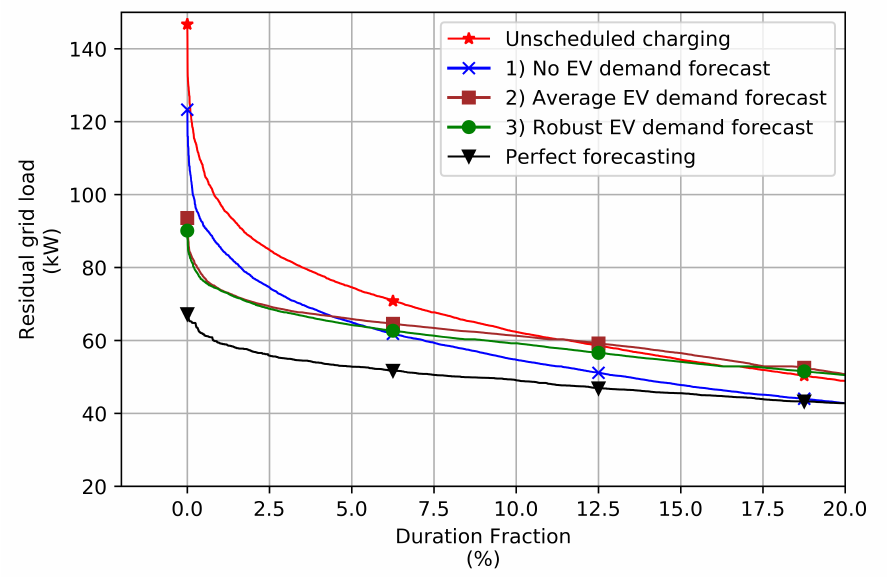
Figure 6. Load duration